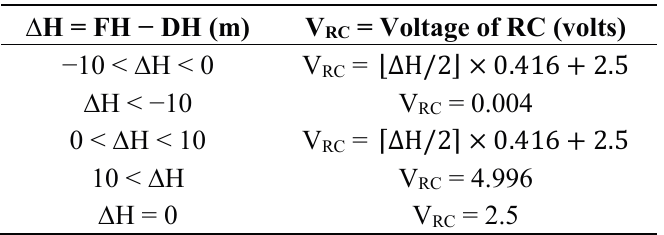
Table 1. Altitude-Voltage